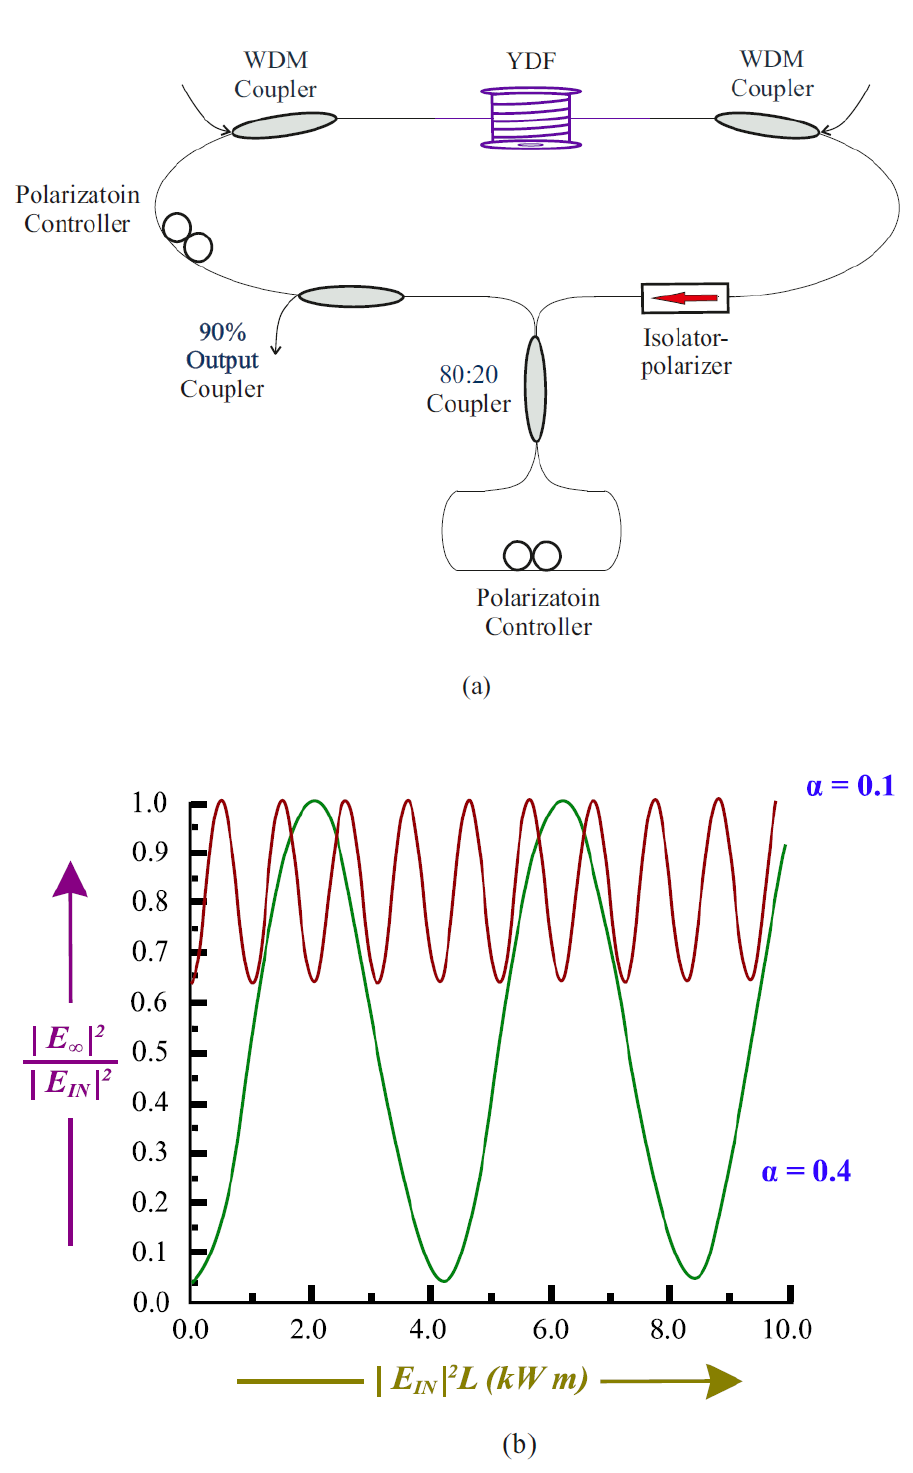
Figure 23. Layout of a laser with a nonlinear loop mirror in the transmission mode and the dependence of the transmittance of the loop mirror: ( a ) layout of a laser with a nonlinear loop mirror in the transmission mode and ( b ) the dependence of the transmittance of the loop mirror in the transmission mode on the input power for different division coefficients α